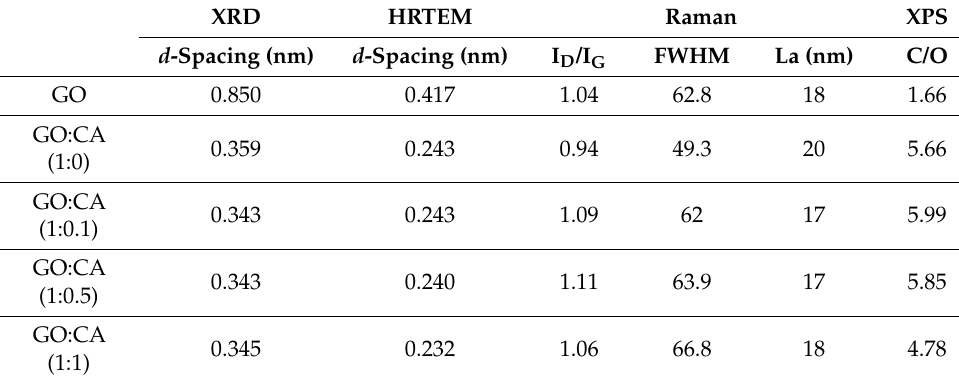
Table 1. Resume of the GO–CA samples’ parameters measured by XRD, HRTEM, Raman and XPS characterization